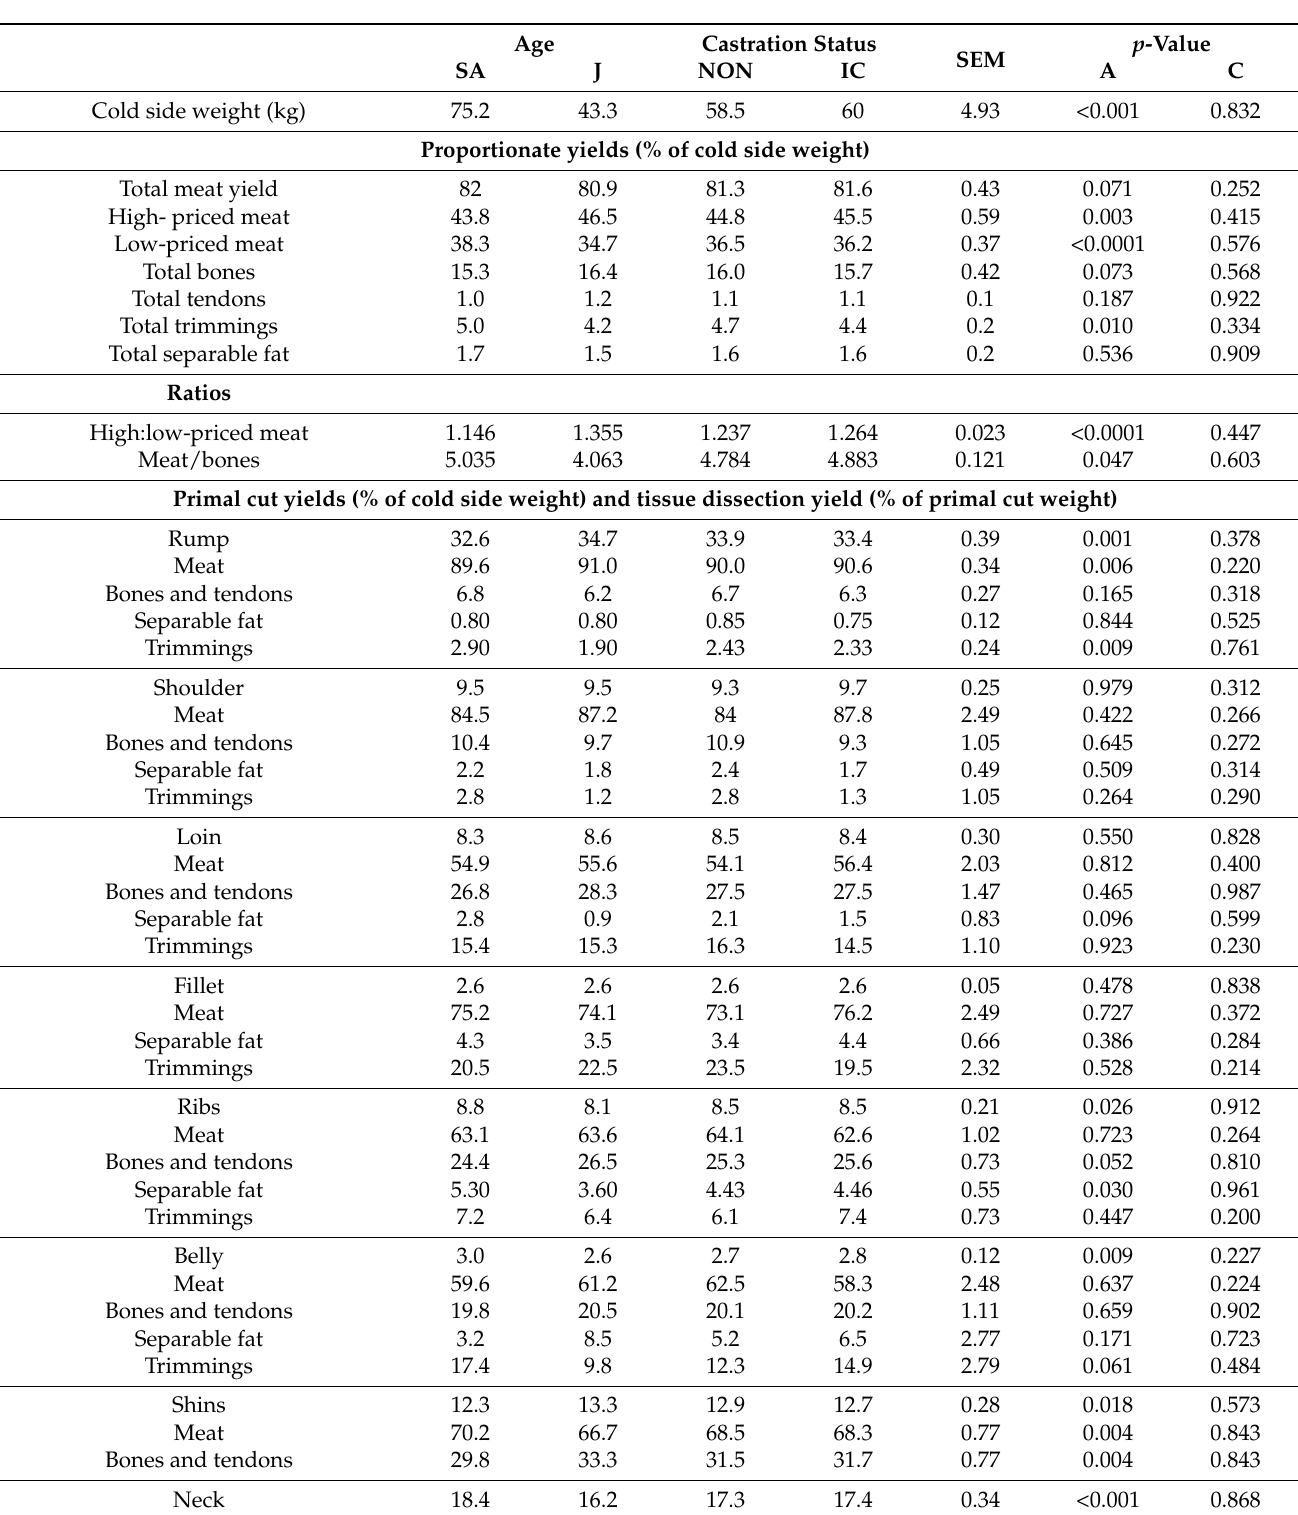
Table 2. Effect of age and castration on the carcass deboning yield of farmed common eland males. Significant differences are reported for the main effects, as no interactions between treatments ( p > 0.05) were